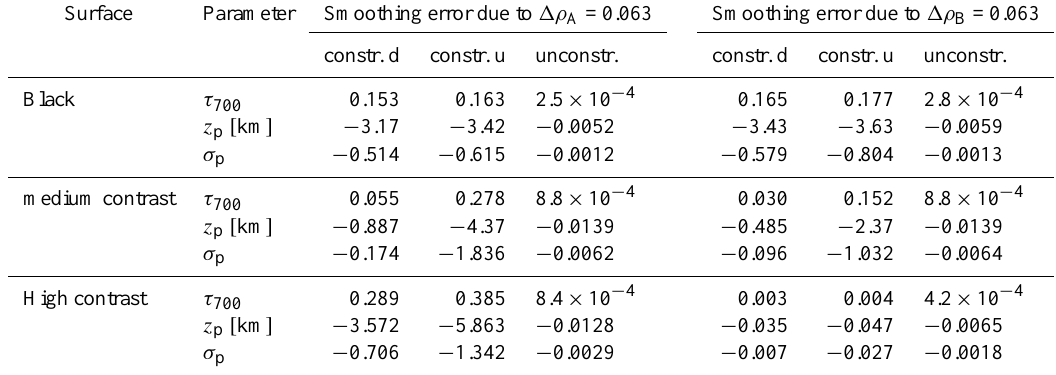
Table 5. Errors caused in the retrieval of other retrieved parameters at the maximum deviation of ρ A and ρ B from their assumed values. Surface